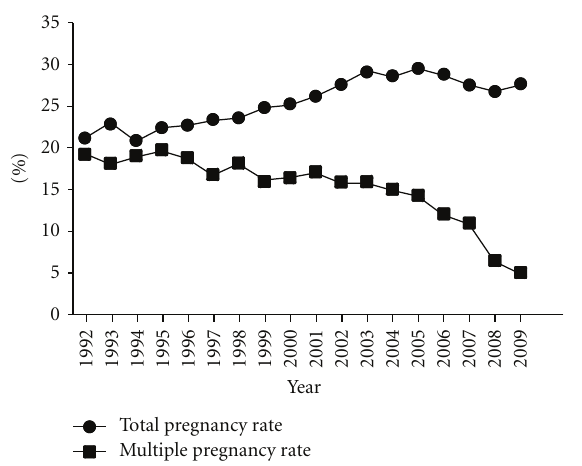
Figure 1: Secular trend of total pregnancy rate and multiple pregnancy rate, 1992–2009.